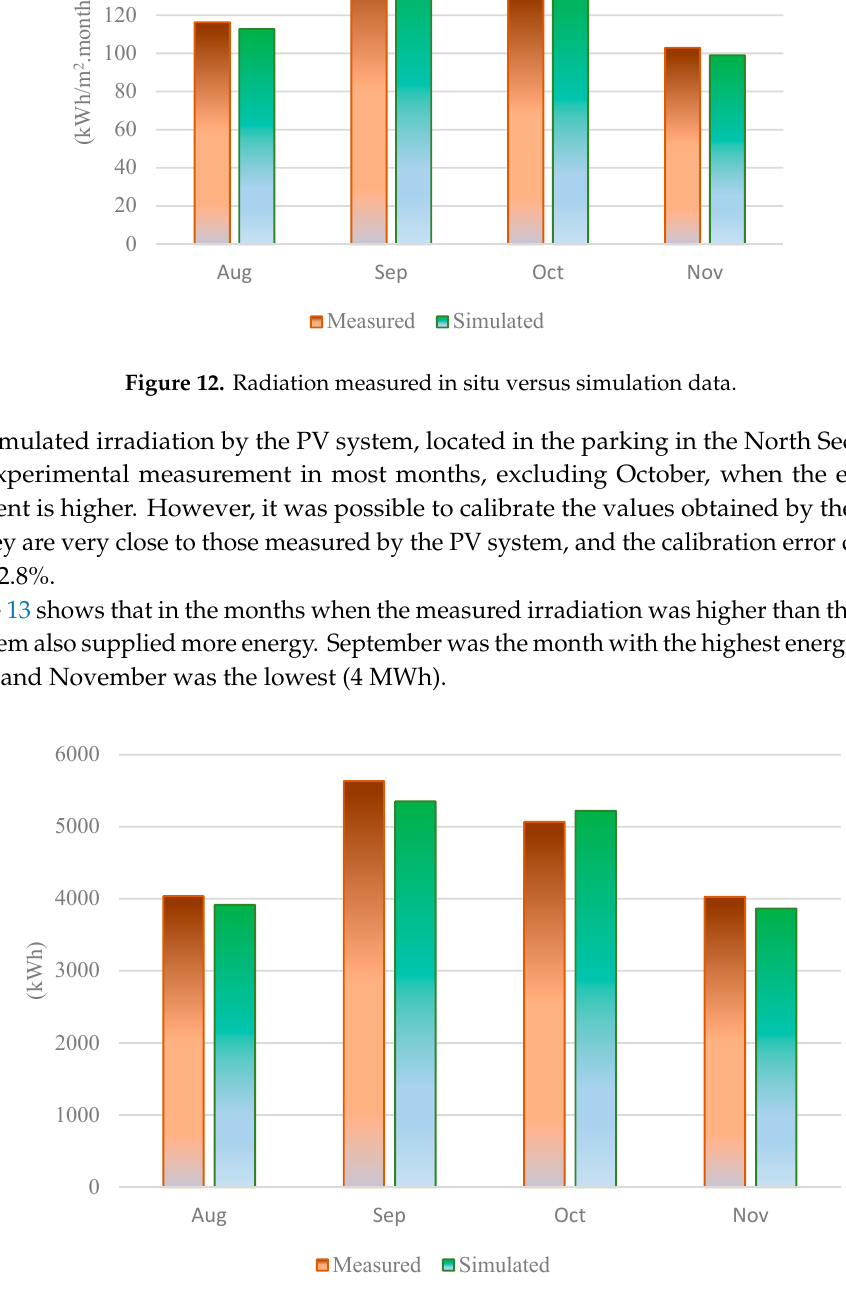
Figure 11. ( a ) Ambient temperature, ( b ) solar irradiance and ( c ) energy produced by the PV system on November 17th (time in hours corresponding to UTC-5).